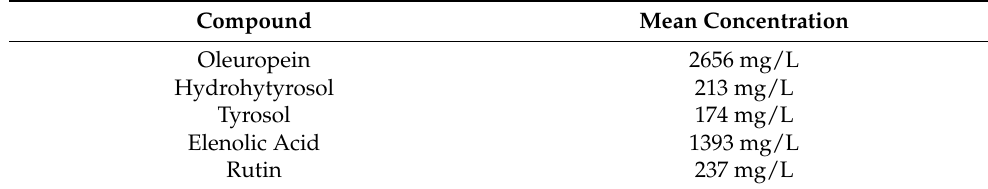
Table 1. Mean concentration of phytochemicals contained in